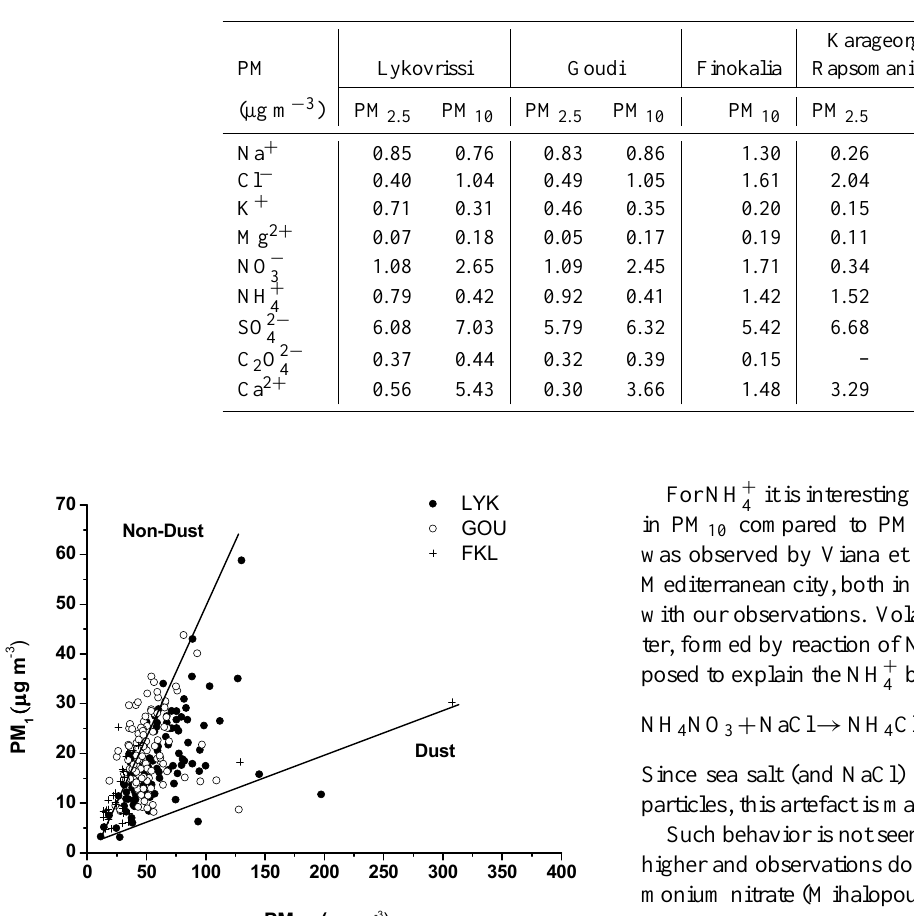
Table 2. Annual mean concentrations of ions (PM 1 , PM 2 . 5 and PM 10 ; µgm − 3 ) measured at Lykovrissi and Goudi from September 2005 to August 2006 and comparison with literature data.